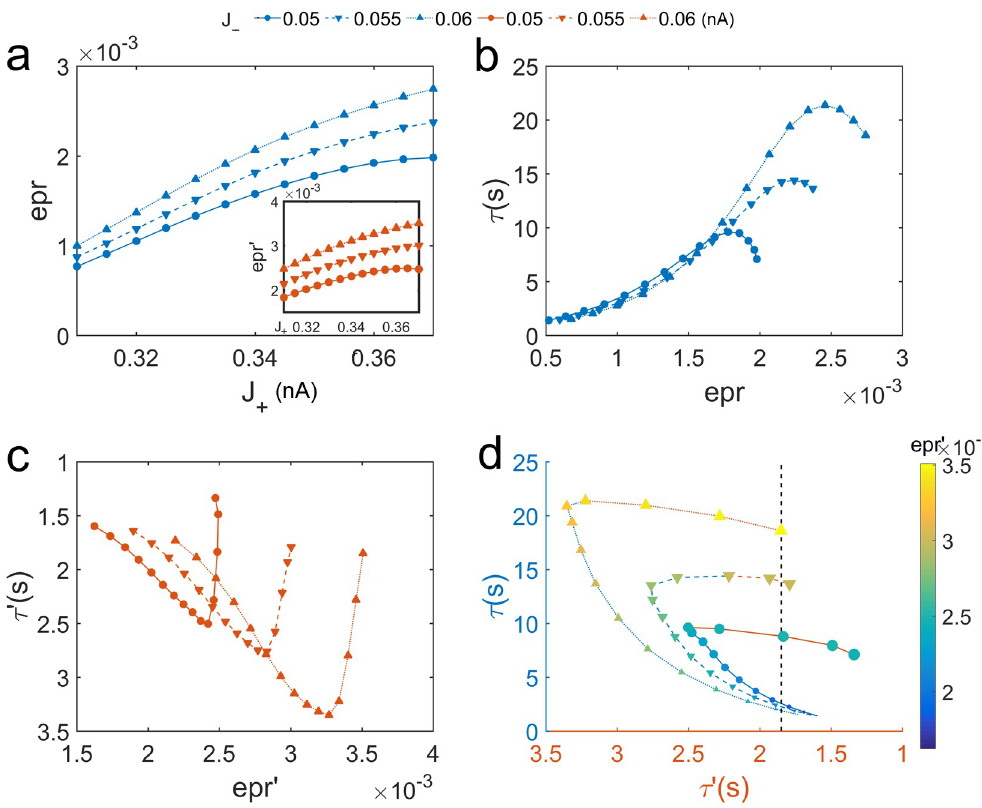
Fig 5. The energy cost quantified by the entropy production rate in working memory. (a)The entropy production rate increases with increasing J + and J − in the absence and presence of a new stimulus. The curves marked with the circles, lower and upper triangles represent different mutual inhibition J = 0.05, 0.055, 0.06 nA , respectively. (b-d)The relationship among − the robustness against random fluctuations, flexibility to a new stimulus and the entropy production rate. (b)Before the emergence of the intermediate state(before the inflection point on each curve), better robustness against the random fluctuations quantified in terms of the MFPT τ requires more energy cost. (c)After the emergence of the intermediate state, the additional energy is used for supporting the new attractor which can enhance the flexibility to a new stimulus quantified in terms of the MFPT τ 0 . The colors of circles in (d) indicate the corresponding entropy production rate. The larger size of markers on each curve indicates stronger self-excitation J +